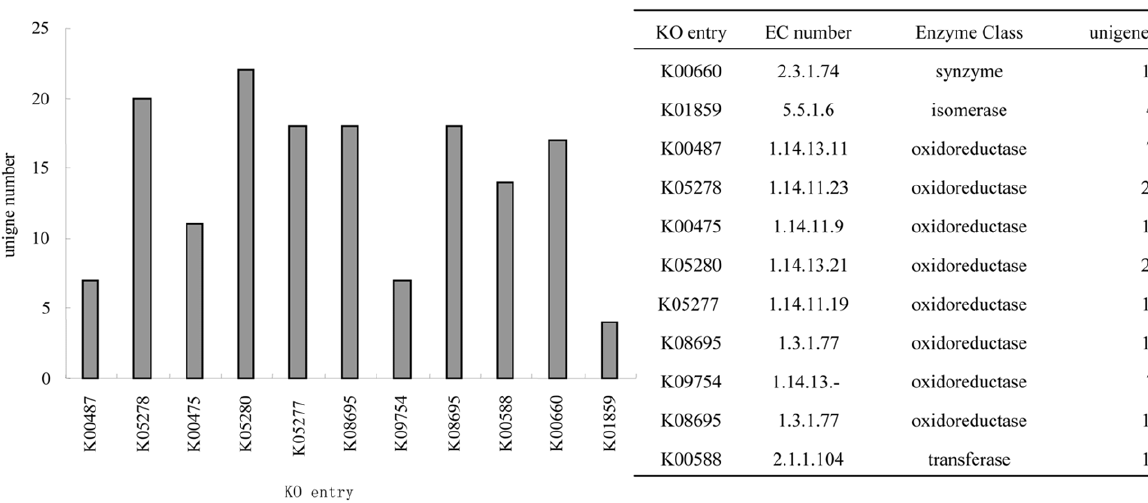
Figure 3. Unigenes predicted to be associated with flavonoid biosynthesis.